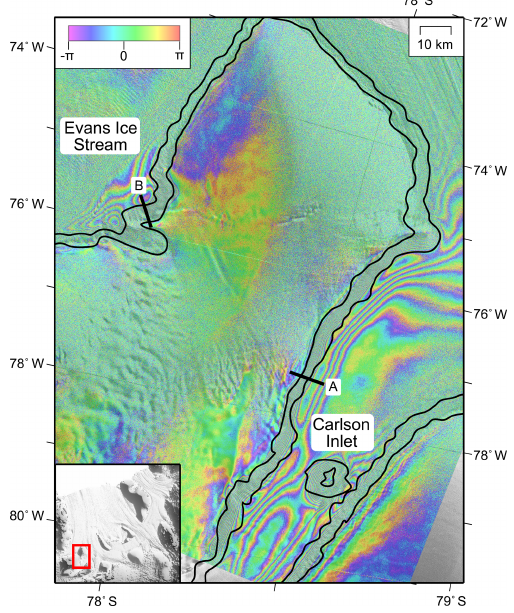
Figure 3. DInSAR interference fringes over the Evans Ice Stream and the Carlson Inlet of the Filchner–Ronne Ice Shelf, along with the CryoSat-2-mapped grounding line (points F and H, solid black lines); each fringe corresponds to 2.8cm change in height due to the motion of tides.